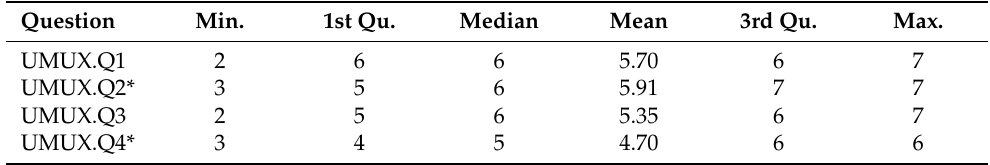
Table 2. Statistical summary of the